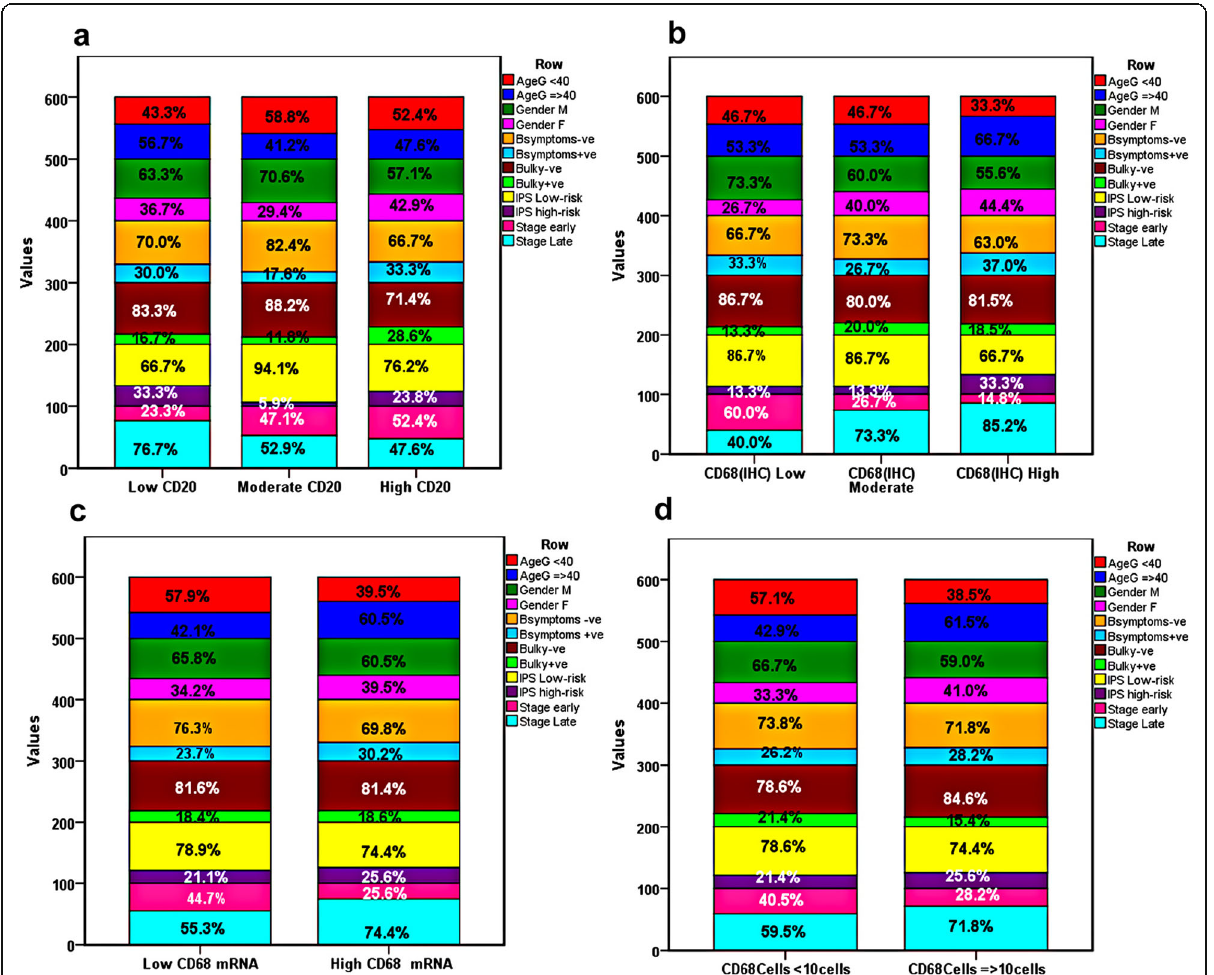
Fig. 3 Correlation between the clinic-pathological features of the patients and a ) CD20 protein expression, b ) CD68 expression by IHC, c ) CD68 mRNA by Rt-PCR, and d ) CD68 + TAM by